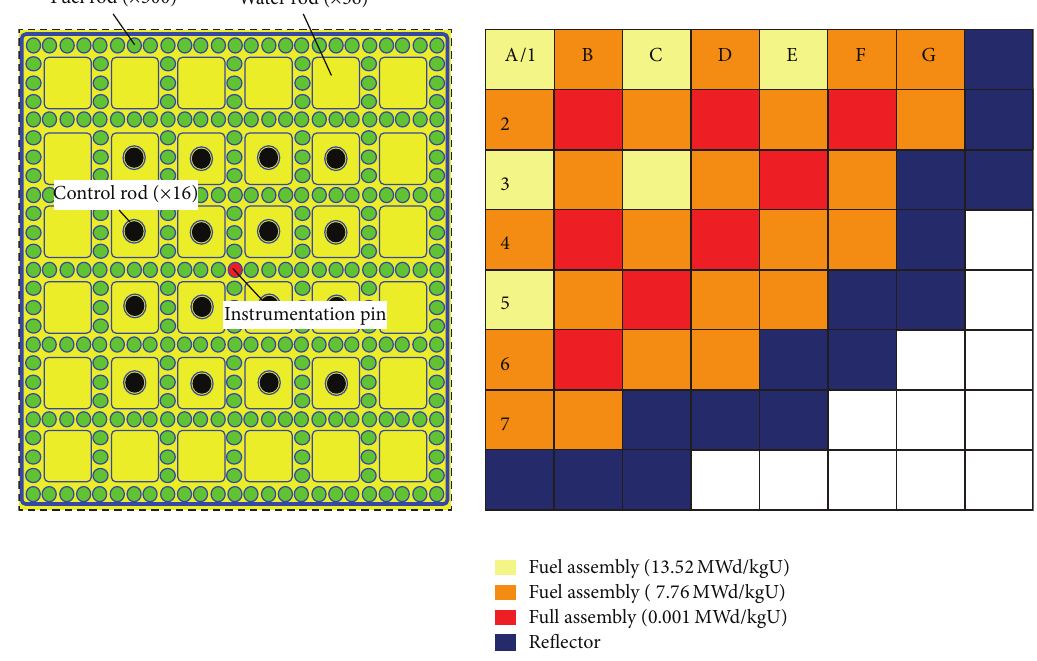
Figure 1: Fuel assembly and quarter core assembly arrangement.